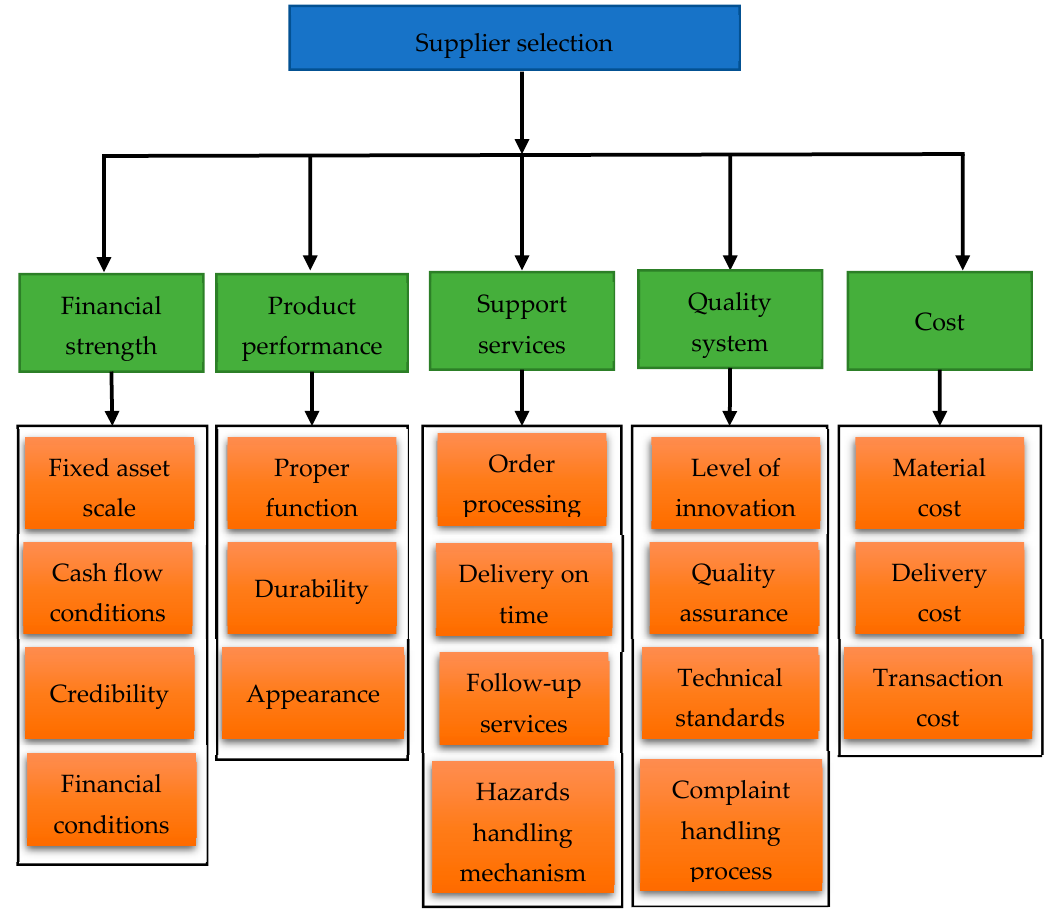
Figure 2. The hierarchy model for selection criteria.